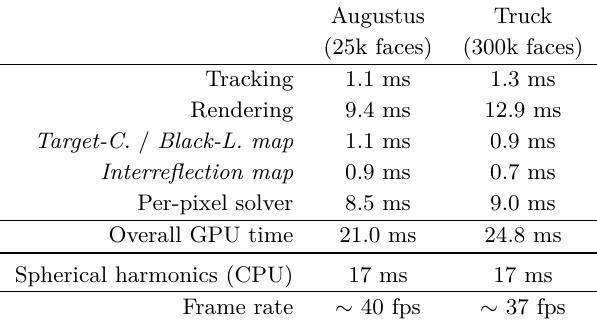
Per-frame performance for all parts of our algorithm. Everything runs on the GPU, except the spherical harmonic calculation, which runs in a concurrent CPU